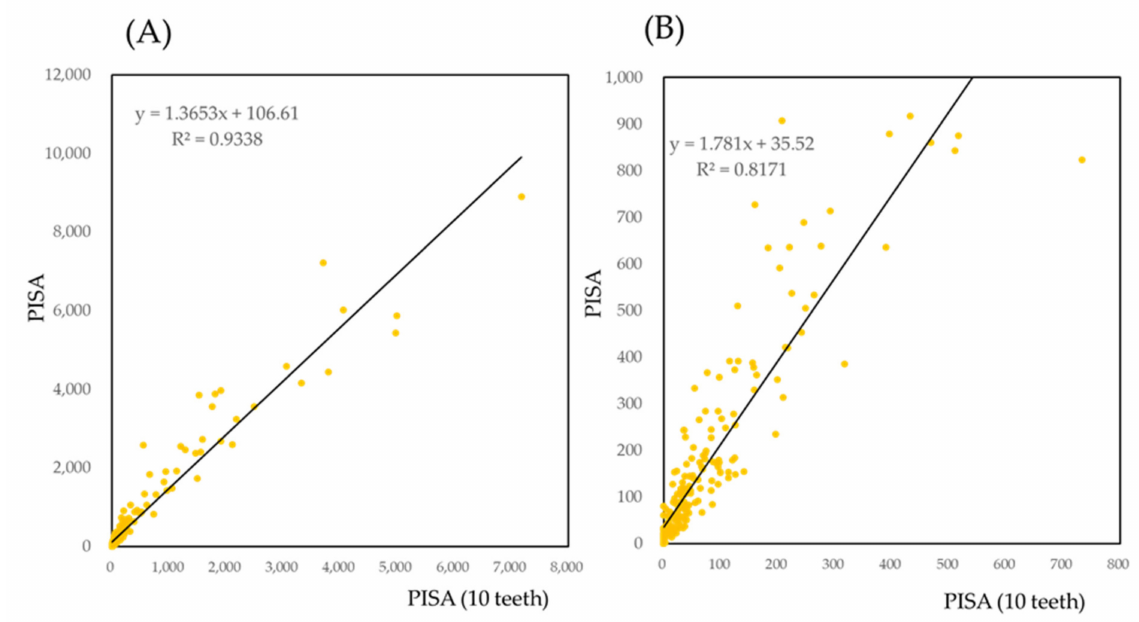
Figure 3. Scatter plot of PISA against the maximum value of PD in each tooth. ( A , B ) are the same figure. ( B ) is magnified PISA for less than 1000. Regression line ( B ) was calculated by PISA less than